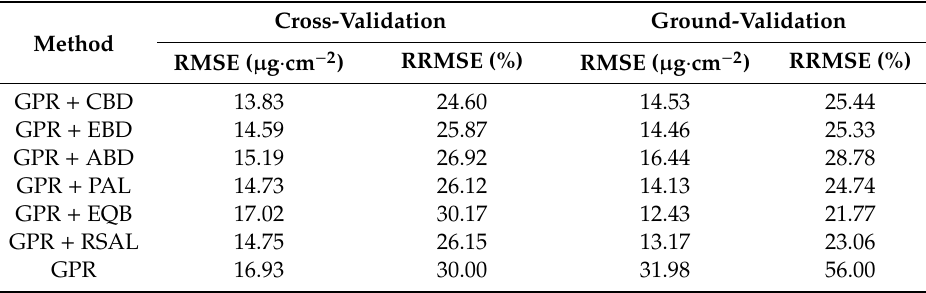
Table 8. Validation results of hybrid regression methods with Landsat-8 OLI